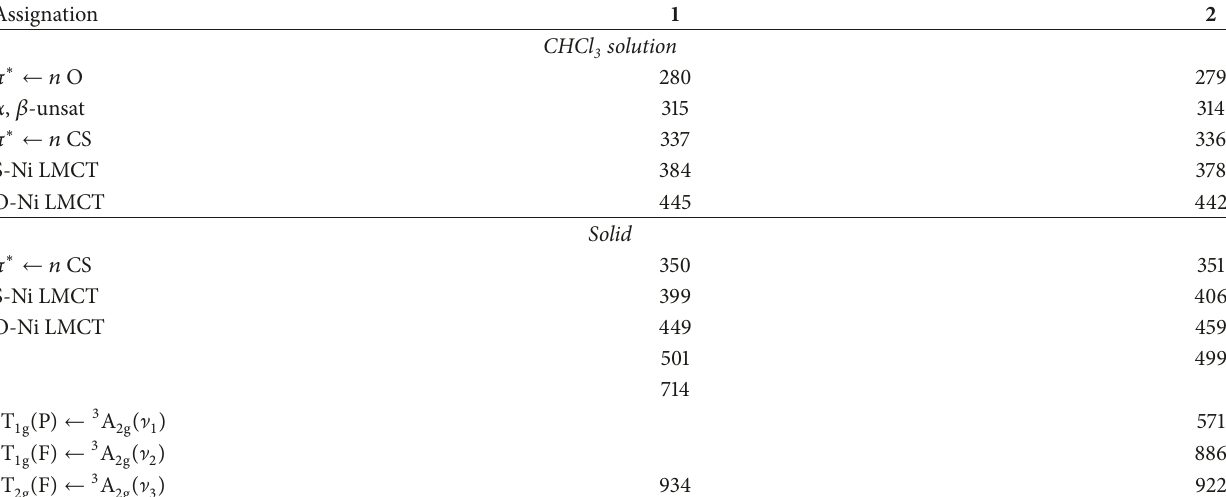
Table 1: Deconvoluted UV–vis signals (nm) of compounds 1 and 2 .